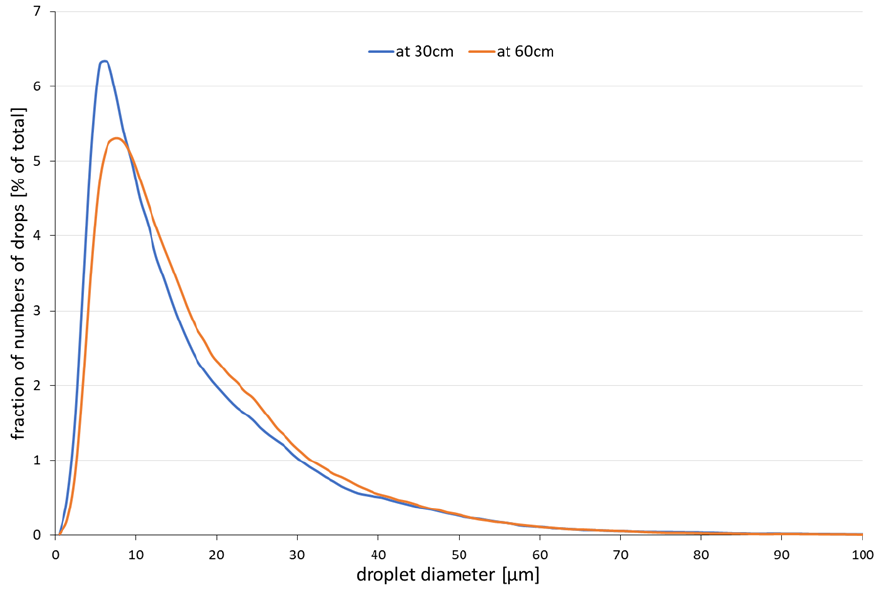
Figure 1. Particle size number distribution in the spray of water droplets at 30 and 60 cm. Table 2. Droplet size characteristics of water droplets spray by volume of the jet spray (mean and standard deviation). More details are presented in Figure S3.